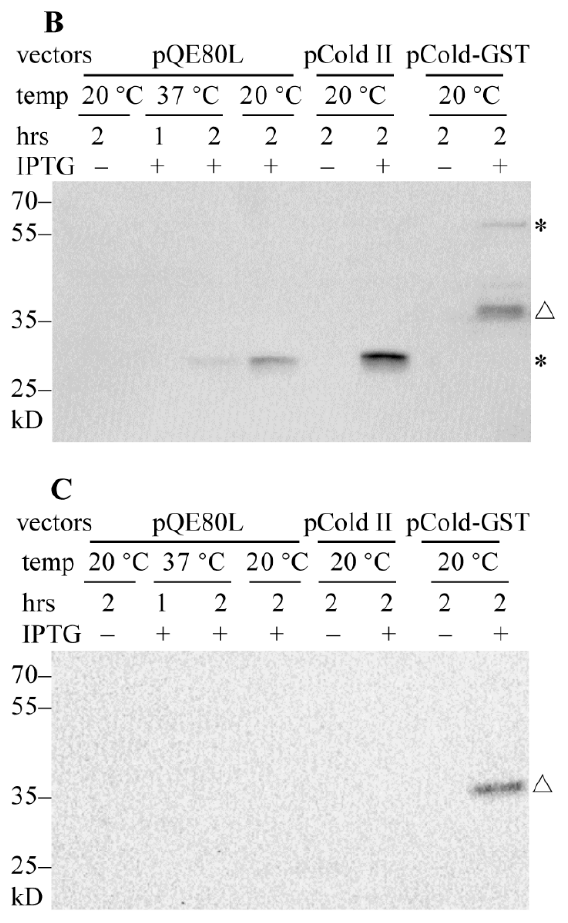
Figure 1. SDS-PAGE analysis of the expressions of recombinant PACRG ( Parkin co-regulated gene). ( A ) Supernatant fractions of the cell lysates were carried on SDS-PAGE and Coomassie brilliant blue (CBB) staining. * denotes the expected migration location of ~60 kD His 6 -GST-PACRG (upper) and ~31 kD His 6 -PACRG (lower); M, protein marker (Thermo). ( B ) WB analysis of recombinant PACRG in supernatant fractions of the cell lysates with PACRG Ab (Abcam). * denotes His 6 -GST-PACRG (upper) and His 6 -PACRG (lower); △ denotes degraded His 6 -GST-PACRG. ( C ) WB analysis of recombinant PACRG in pellet fractions of the cell lysates with the same Ab. △ denotes ~38 kD degraded His 6 -GST-PACRG. ~30 µg protein was loaded for each sample.